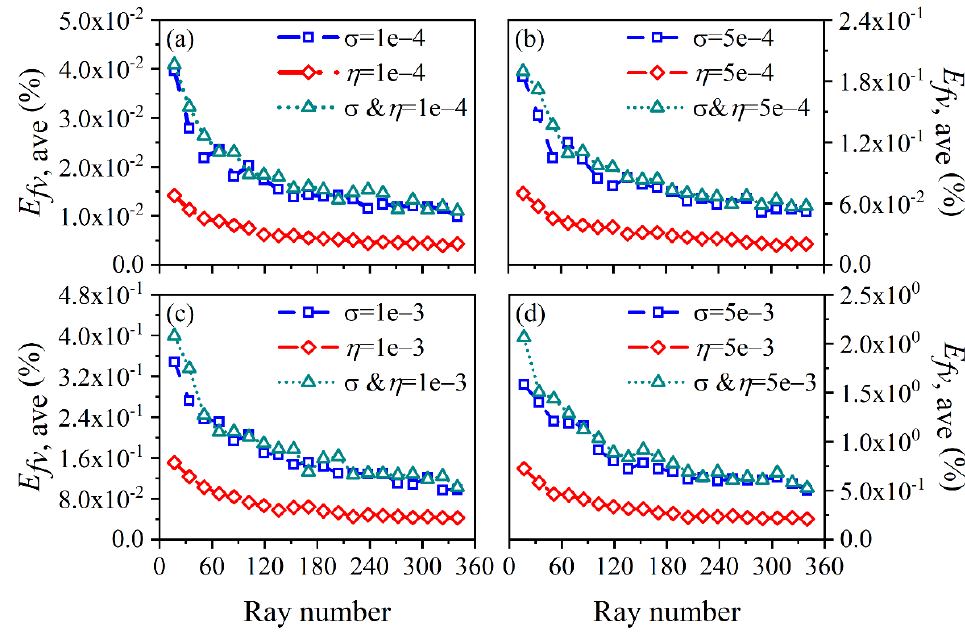
Figure 5. The average relative reconstruction error for soot volume fraction under different ray numbers considering the measurement error of the radiation intensity and coefficient matrix. ( a )